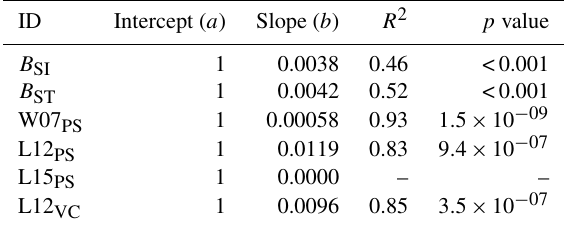
Table A4. Slopes and intercepts of biomass dose–response relation- ships for needleleaf species simulated by O-CN versions based on published injury functions to net photosynthesis or V cmax (see Ta- ble 1). B SI and B ST represent the simple and standard model by Büker et al. (2015). A dash (“–”) indicates that no values were avail- able.